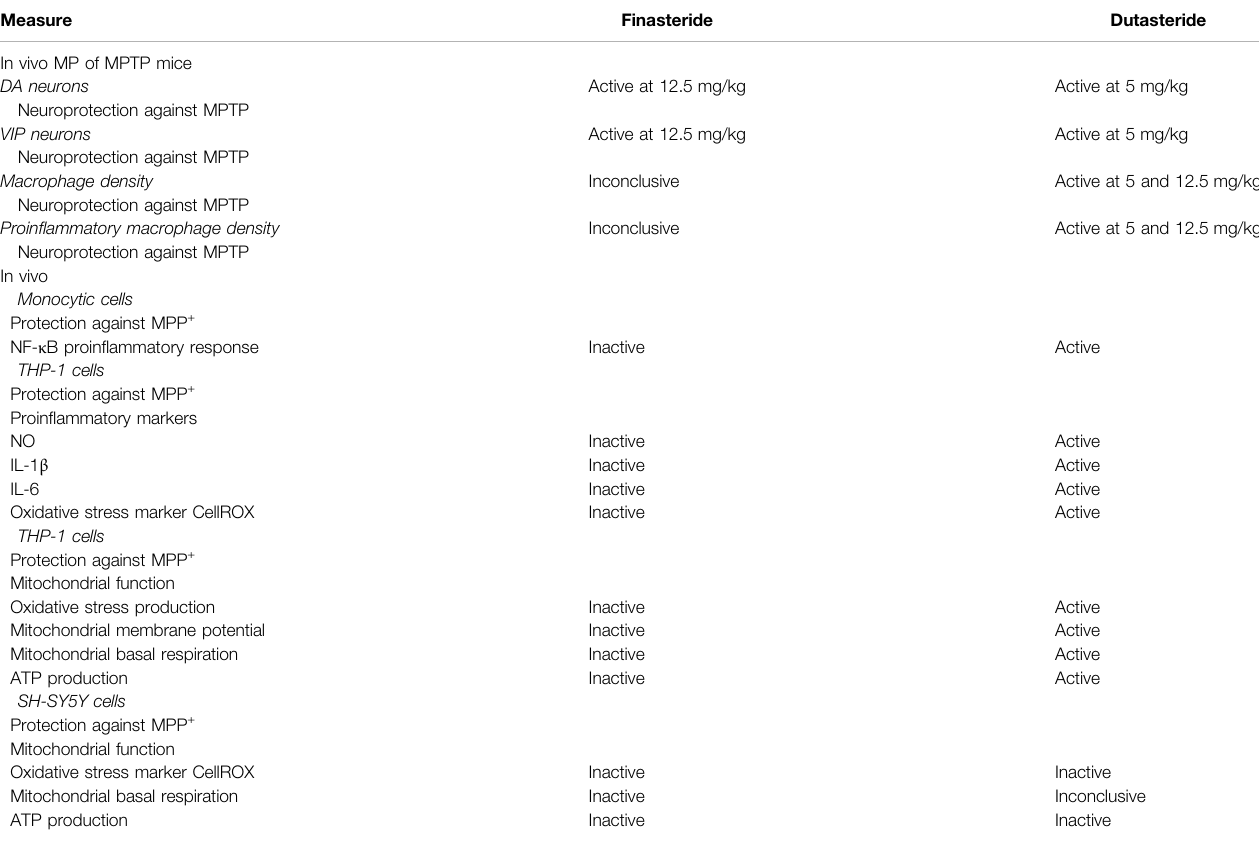
TABLE 1 | Summary of the effects of fi nasteride and dutasteride treatments reported in this study.